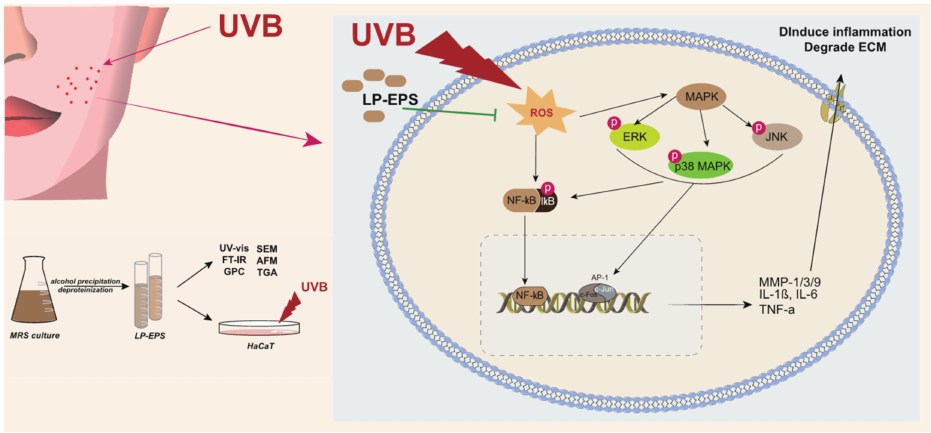
Figure 6. Pathways of action of LP-EPS to treat or ameliorate UVB-induced skin